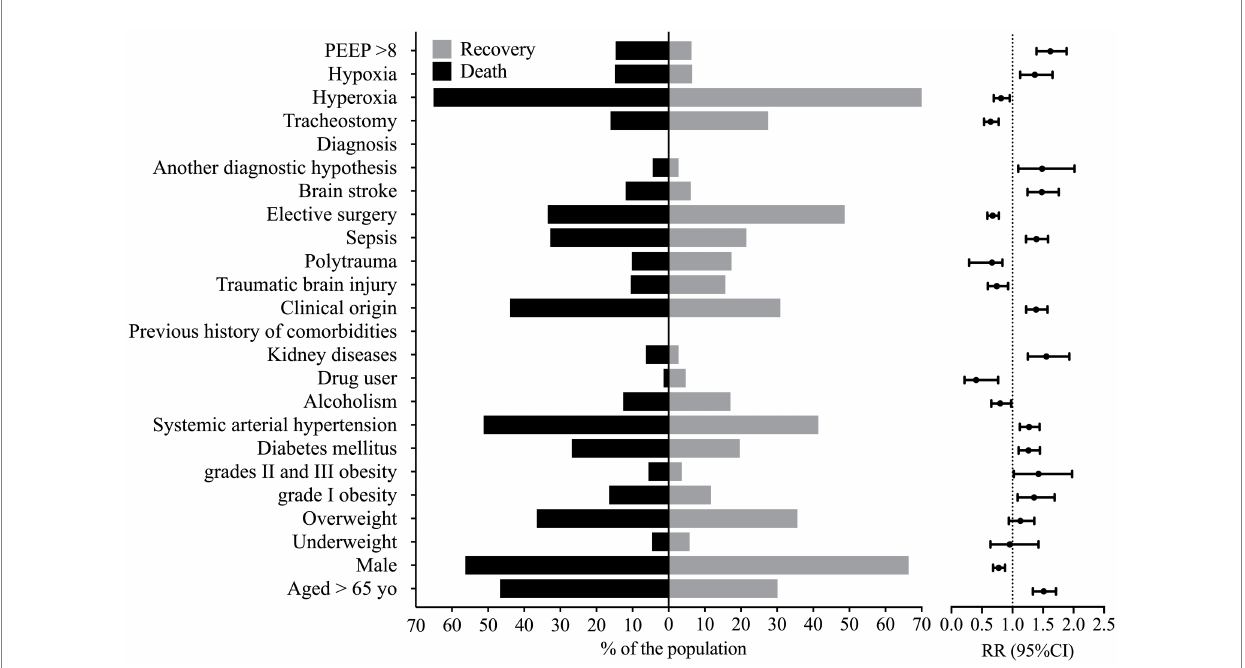
FIGURE 1 Markers that presented statistical significance in the association between patients that died and those that were discharged from the hospital. This figure shows the percentage of individuals that presented a marker according to the outcome and the relative risk, whose reference was the percentage of individuals discharged from the hospital against the group of patients that died. PEEP, positive end-expiratory pressure; RR, relative risk; yo, years old; 95%CI, 95% confidence interval. We carried out the statistical analysis using the Fisher Exact test or the Chi-square test and a 0.05 alpha